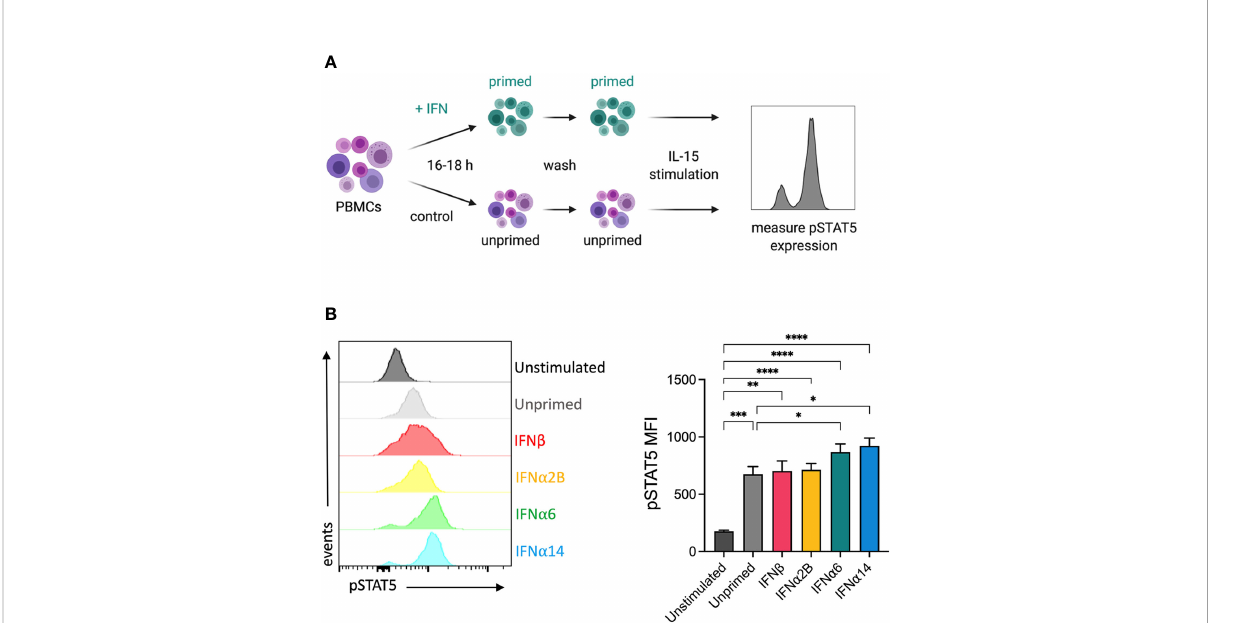
FIGURE 4 IFN a 6 and IFN a 14 activation primes NK cells to respond to IL-15 stimulation (A) Experimental design. PBMCs were either left unstimulated or were primed with 100 IU mL -1 of IFN b , IFN a 2B, IFN a 6 or IFN a 14 overnight. Following overnight activation, cells were washed and then assessed for the expression of phosphorylated STAT5 (Y694) at baseline (unstimulated) or following stimulation with 5 ng mL -1 IL-15 for 15 mins. (B) Representative histogram plot shows per-cell pSTAT5 expression in unstimulated, unprimed, and IFN-I primed CD56 + CD3 - NK cells. Summary data show mean ± SEM pSTAT5 MFI in unstimulated, unprimed, and IFN-I primed NK cells. n = 10 healthy donors, 3 independent experiments. Data were compared using a paired Student ’ s t test. * p < 0.05, ** p < 0.01, *** p < 0.001, **** p <